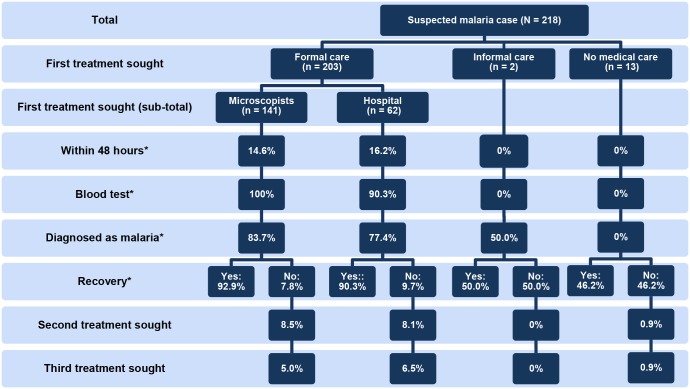
Treatment seeking behavior.* Significant difference (p < 0.05) between groups divided by first treatment sought.